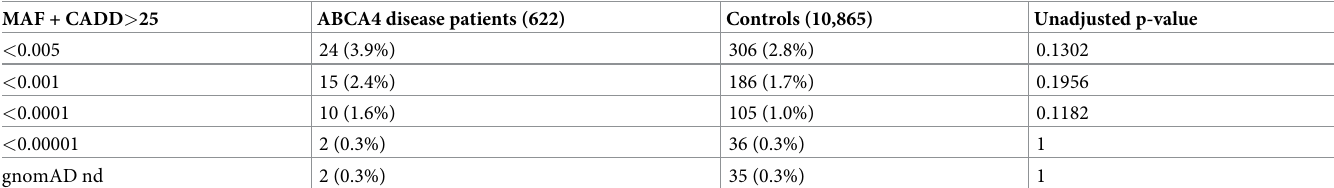
Table 1. Heterozygous individuals in ABCA4 disease and control cohort harboring rare variants in macular dystrophy genes CDHR1 , CHM , CRX , ELOVL4 , PROM1 , PRPH2 , ROM1 . All comparisons were performed with the two-sided Fisher’s Exact Test (FET). MAF, minor allele frequency; gnomAD, genome aggregation database; CADD, combined annotation dependent depletion; nd, not detected.